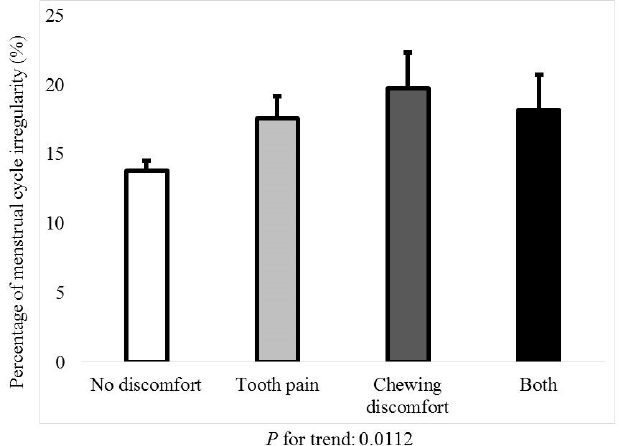
Figure 1. Percentage of menstrual cycle irregularity in the individuals with tooth pain and/or chewing discomfort.